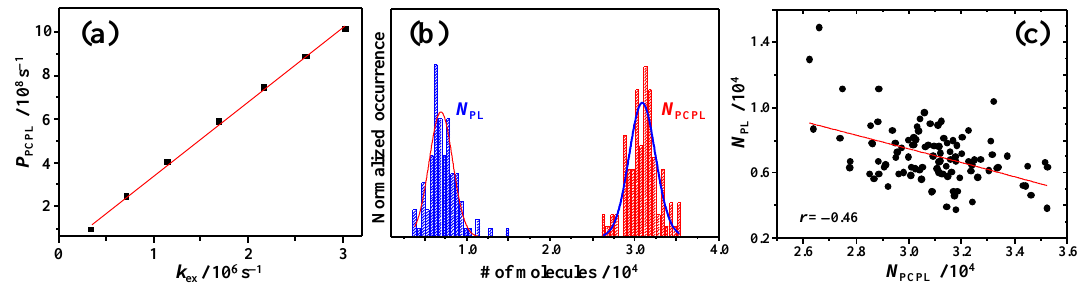
Figure 5. ( a ) Excitation rate dependence of photon count rate of “PCPL-dye” ( P PCPL ). ( b ) Histograms of the numbers of “PCPL-dye” ( N PCPL ) and “PL-dye” ( N PL ) molecules at 100 different local positions of a MK-2-DSSC. ( c ) Correlation plot between N PCPL and N PL (correlation coefficient r = −0.46).